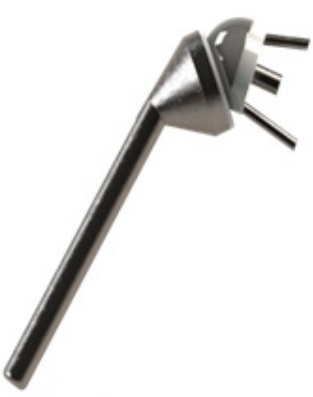
Figure 2. The design of the Delta 3 model of a total inverted shoulder prosthesis.